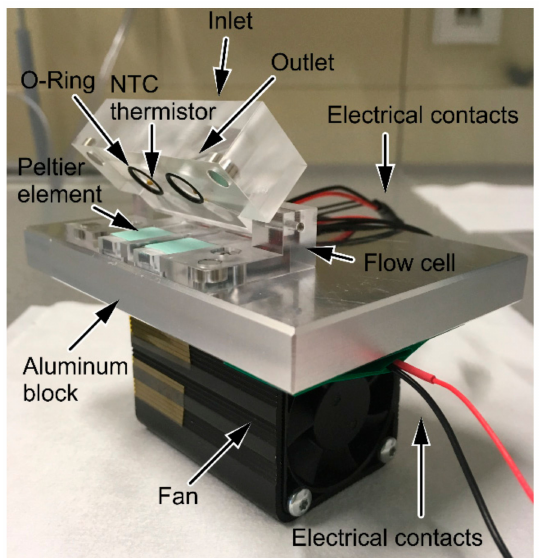
Figure 2. Flow cell for temperature-controlled measurements. Flow cell mounted on aluminum block with fan. Two measurement compartments for dual measurement are available. Temperature control was realized by Peltier elements on the bottom of the cell with thermally conductive pads. In the lid of the cell: inlet, outlet, O-rings, and NTC thermistors. Electrical contacts of the fan and the Peltier elements are shown as